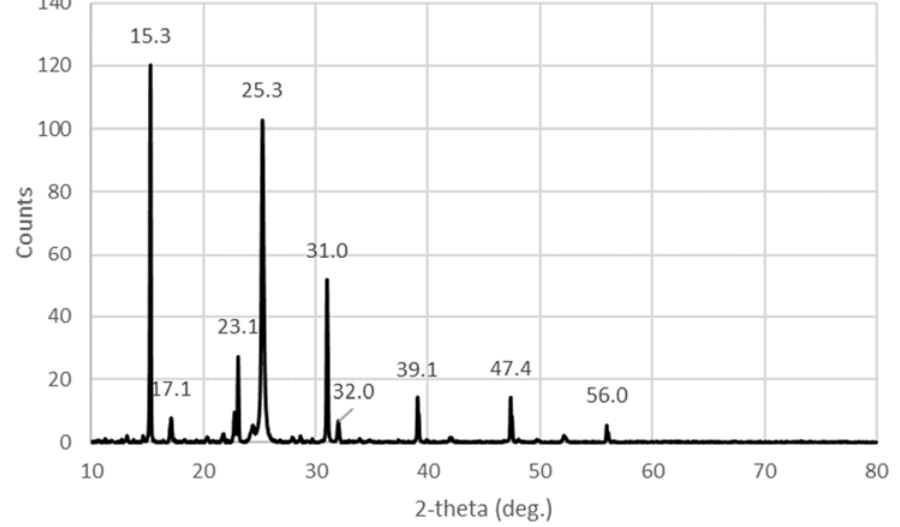
Figure 4. The XRD analysis of [Cu(12-crown-4) 2 ]I 5 . The strongest peaks, 2 θ = 15.3 ◦ (111) and 25.3 ◦ (220), in the XRD analysis belong to iodine and pentaiodide species, respectively (Figure 3) [25,29,30,33]. Further peaks at 17.1 (301), 47.4, 39.1, 31 (222), and 23.1 ◦ are assigned to iodine molecules according to previous investigations